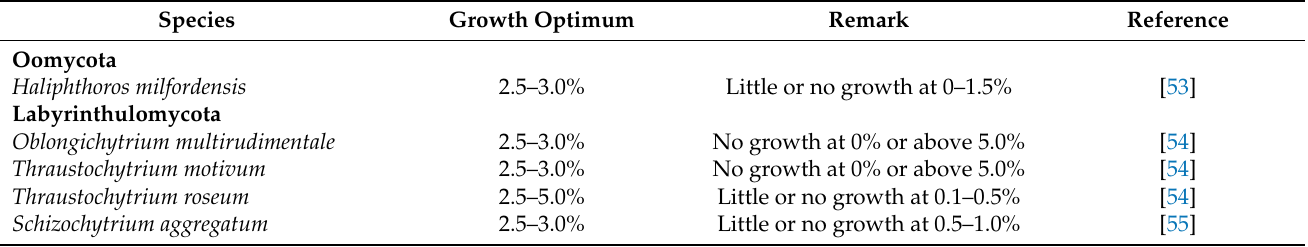
Table 2. Growth of marine Oomycota and Labyrinthulomycota in various concentrations of sodium chloride.